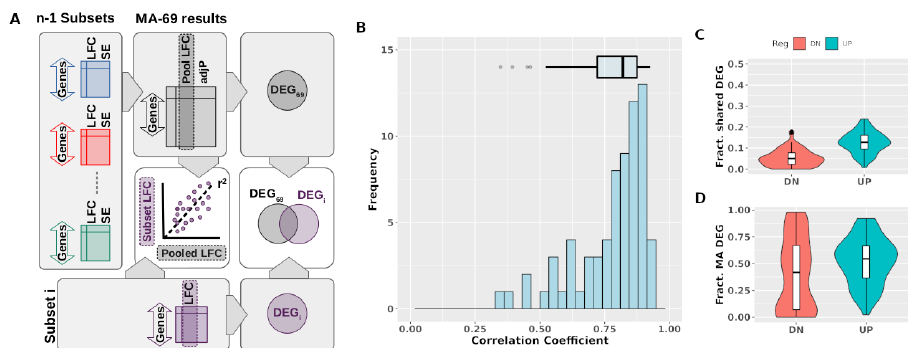
Figure 5. Meta-analyses accurately predict the identity of DEG and the magnitude of the change in their expression. ( A ) Diagram depicting the procedure to assess meta-analyses consistency using leave-one-out cross-validation. For each iteration, a meta-analysis spanning 69 subsets (“MA-69”) was performed, and then the concordance between expression changes in the individual subset left out and the pooled estimates in the MA-69 was calculated (central column in the diagram). In addition, the list of differentially expressed genes derived from the meta-analysis (“ DEG 69 ”) and from the individual transcriptome (“ DEG i ”) were compared to assessed their overlap (right column in the diagram). The whole procedure shown in panel A was repeated leaving out a different subset each time until all possibilities were exhausted. The distribution of the 70 resulting correlation coefficients is shown in panel B and the overlap between DEG lists in panels C and D. ( B ) Histogram and boxplot showing the distribution of the Pearson’s correlation coefficients between the pooled estimates and the actual effect size observed in each left-out subset. ( C ) Genes showing a statistically significant ( FDR < 0.01) change in expression were obtained from each meta-analysis ( DEG MA ) and the corresponding left-out individual subset ( DEG i ). The overlap between both lists of DEGs was calculated as | DEG MA ∩ DEG i | . The graph represents the distribution | DEG MA ∪ DEG i | of the overlap values obtained in the 70 iterations of the process. To facilitate the comparison, the graph uses the same y-axis scale than the one in Figure 1C. ( D ) A list of “core” hypoxia responsive genes was derived from each meta-analyses as ubiquitous genes (expression detected in at least 90% of the datasets included in the meta-analyses) showing a robust ( | LFC | > 0.7) and significant ( FDR < 0.01) change in expression ( DEG core ). This list was then compared the list of genes showing a significant ( FDR < 0.01) change in expression in the remaining subset ( DEG i ). The proportion of “core” genes present in the DEG from the individual experiment was calculated as | DEG core ∩ DEG i | . The graph represents the distribution of the values obtained in the 70 iterations of | DEG core | the